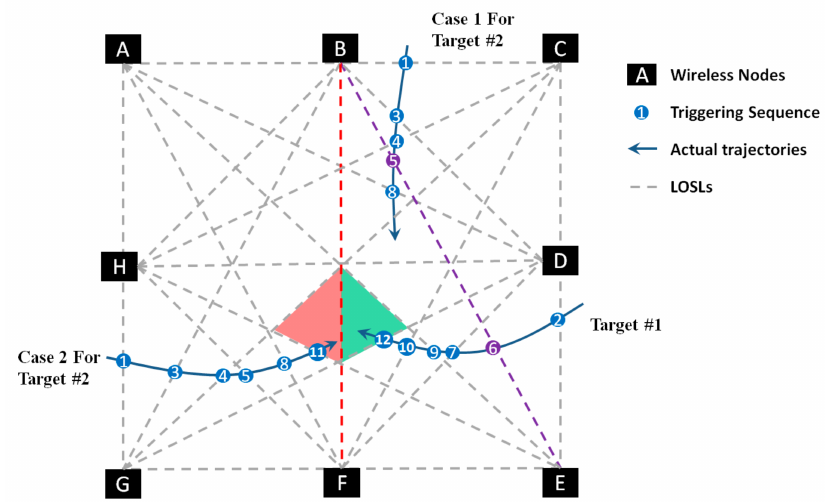
Figure 4. Scenarios for two cases of two targets. For the first case, it is possible to uniquely distinguish the two trajectories separately, while predicaments will happen in the second case.